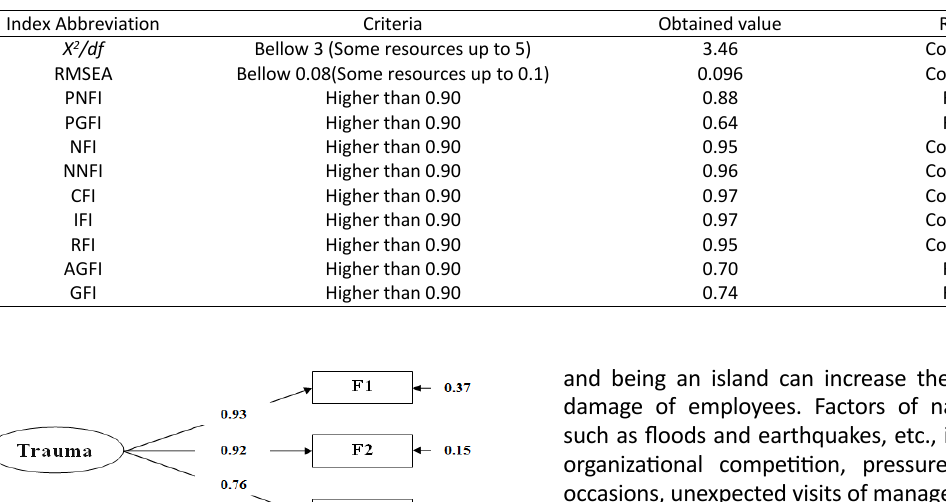
Table 8. Results of goodness of fit test of organizational trauma model data collection